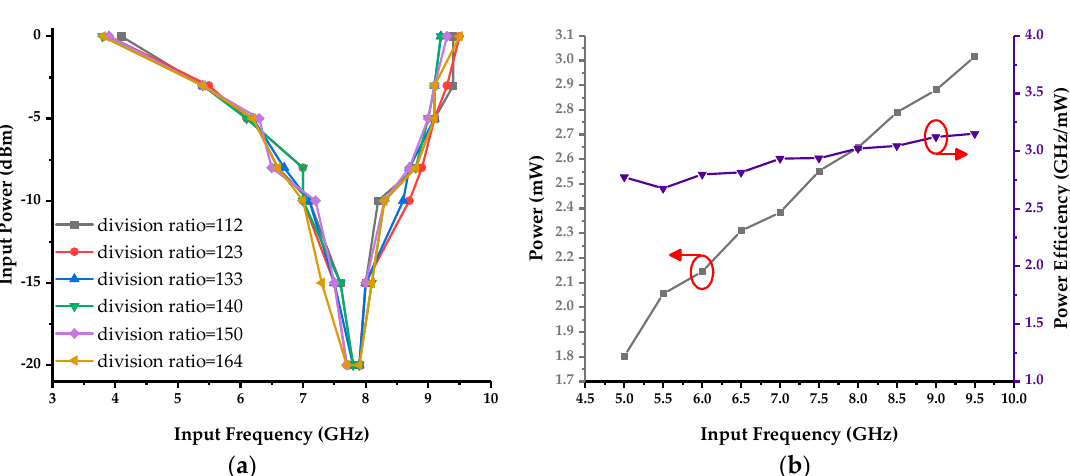
Figure 11. ( a ) Measured input sensitivity curve of MMD in different division ratio; ( b ) Simulated power and power efficiency of the proposed MMD.